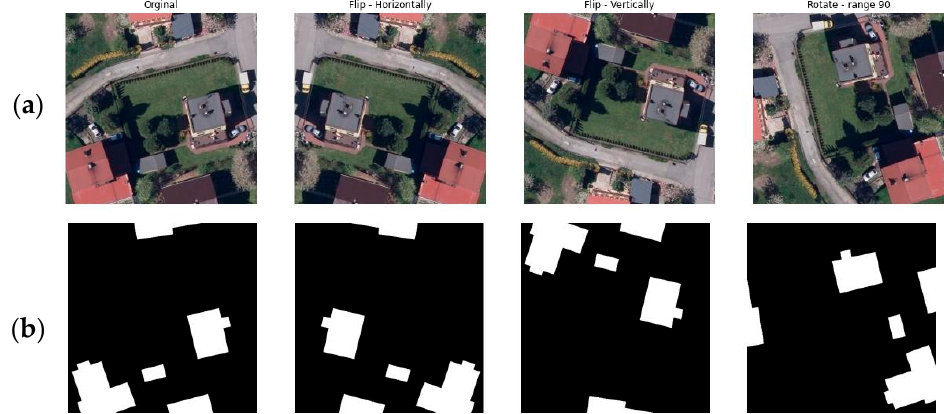
Figure 6. Example of augmented data: ( a ) images ( b ) masks